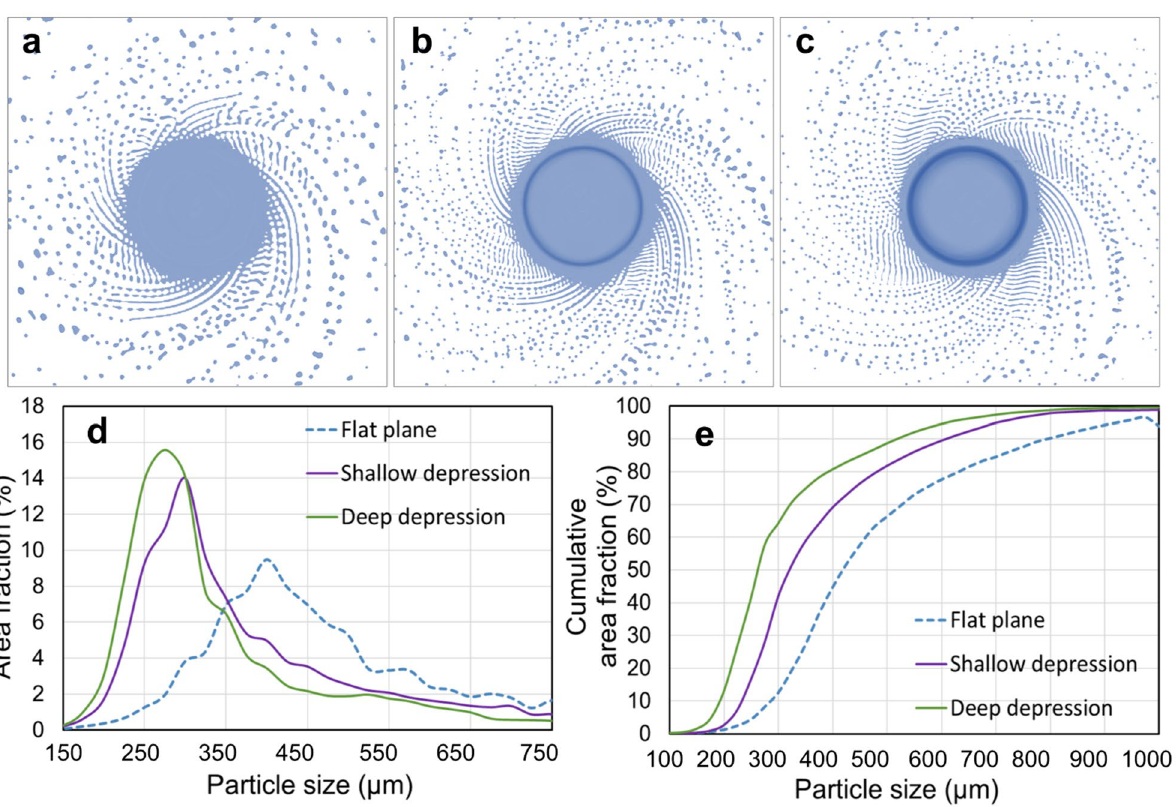
Figure 11. ( a – c ) CtFD-simulated PREP process of Ti64 and ( d , e ) corresponding PSD fabricated with the end surface morphology of ( a ) flat plane, ( b ) shallow depression, and ( c ) deep depression. Electron diameter was 15 mm; rotating speed was 7000 rpm; melting rate was 7.5 × 10 –7 m 3